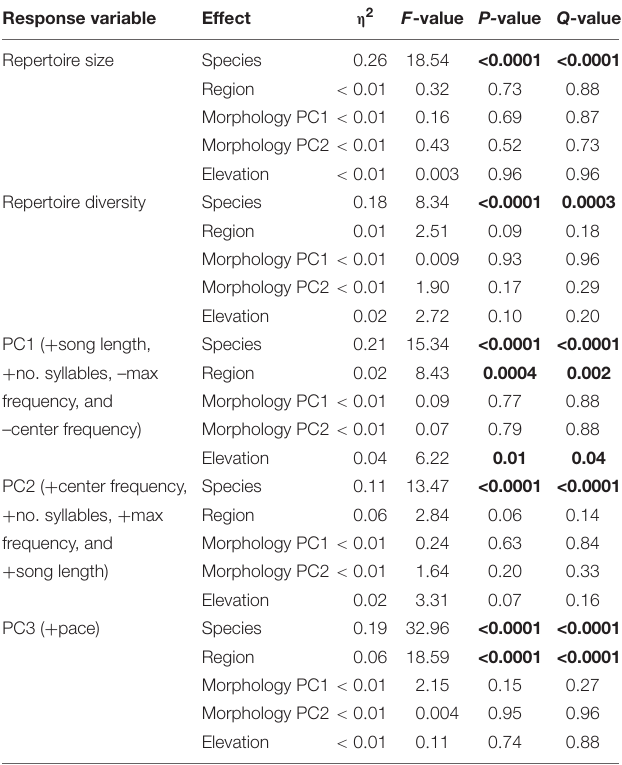
TABLE 3 | Linear model results for different measures of variation in the general characteristics of indigobird non-mimicry songs. Response